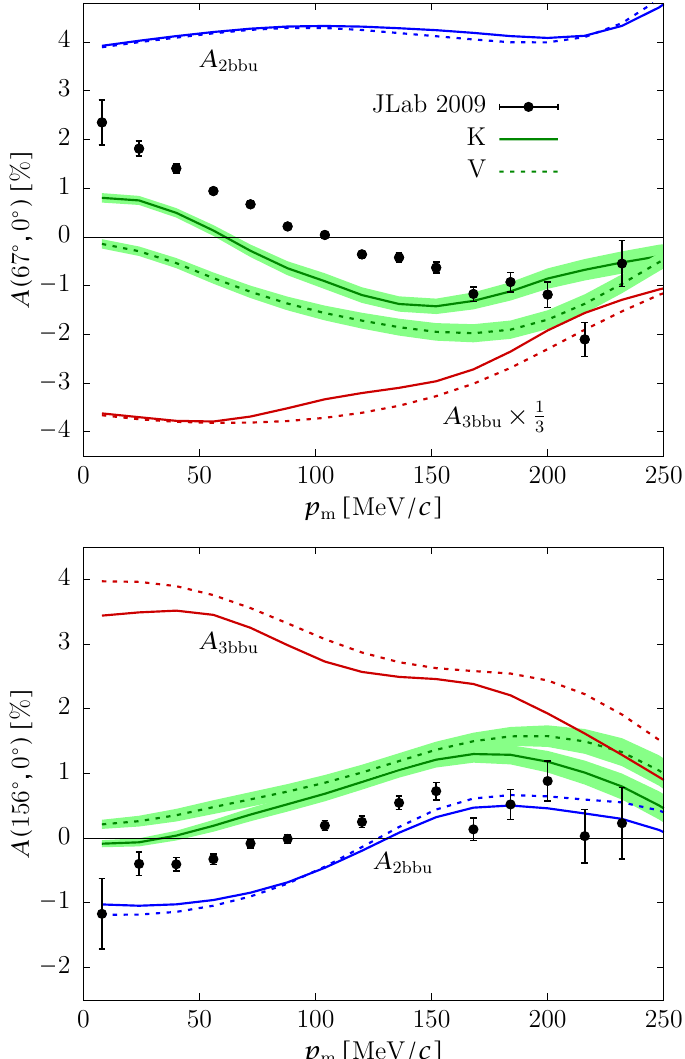
Figure 2: The measured asymmetries A ( 67 ◦ ,0 ◦ ) (top) and A ( 156 ◦ ,0 ◦ ) (bottom) in (cid:126) the quasi-elastic 3 He ( (cid:126) e,e (cid:48) p ) process as functions of missing momentum, compared to the acceptance-averaged K and V calculations (see text for notation). The calculated two-body and three-body breakup contributions are also